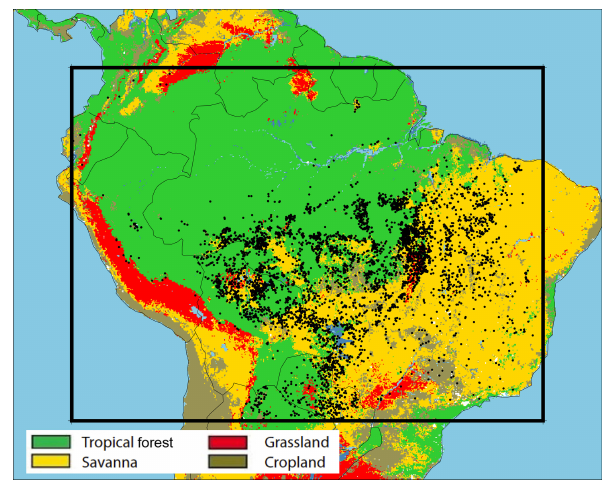
Figure 2. Locations of the MISR plumes analysed (black dots) over the four main biomes considered in the study. The black square rep- resents the Amazon domain.